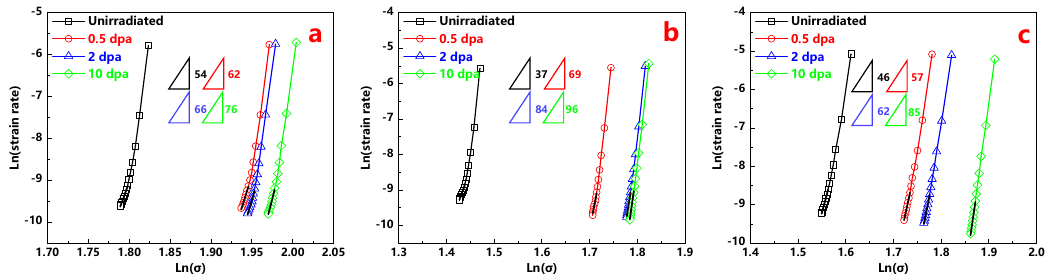
Figure 6. Ln (strain rate) versus ln ( ∆ ) profiles of the ( a ) Hastelloy N alloy; ( b ) Alloy 800H; ( c ) 316H stainless steel are plotted to compute n values of secondary stage.